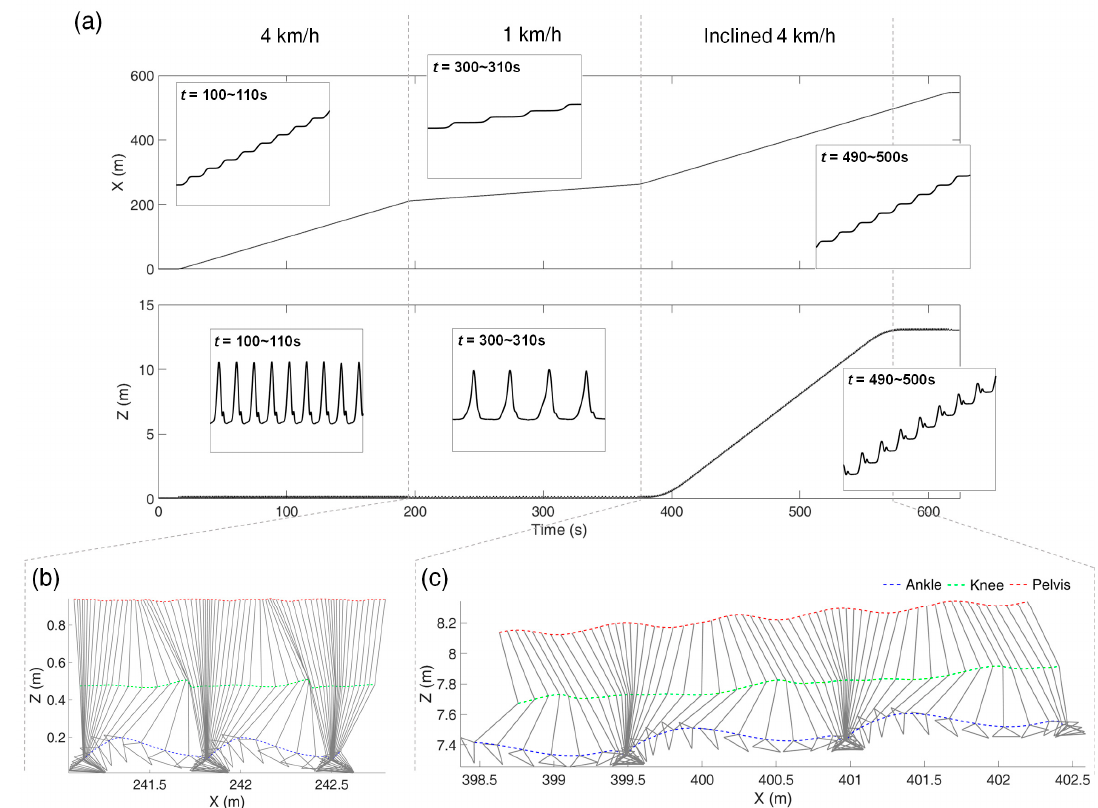
Figure 6. Mapping results from Trial 6 of the variable-speed tests with various inclinations: ( a ) shows the x - and z -axes ankle marker trajectories with respect to time, ( b , c ) show marker trajectories on the sagittal plane after the mapping, during 1 km/h walking without inclination ( t = 300–306 s) and during 4 km/h with the inclination of 4 ◦ ( t = 490–493 s), respectively.